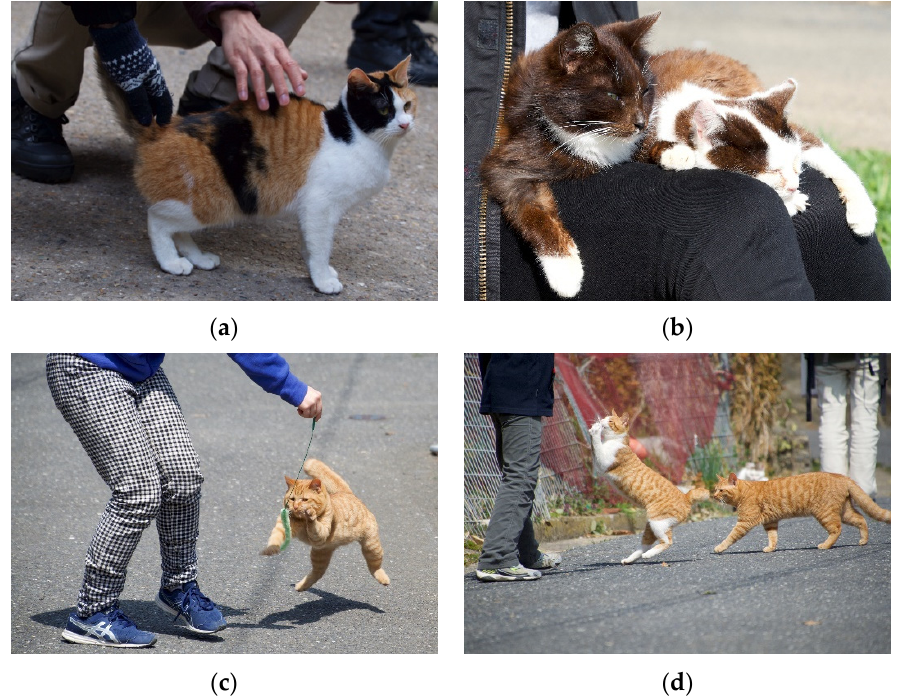
Figure 3. Photos of FRC–human social interactions taken by K. Vitale: ( a ) Cat–human interaction at Fushimi Inari, a shrine in Kyoto, Japan. A FRC accepts petting from multiple people at once; ( b ) FRCs on Tashirojima, an island in Japan, sit on the lap of an unfamiliar human; ( c ) a visitor to Tashirojima plays with a resident cat using a toy; ( d ) another visitor to Tashirojima uses a toy to play with a cat. Other cats start to gather to take turns playing with the toy.